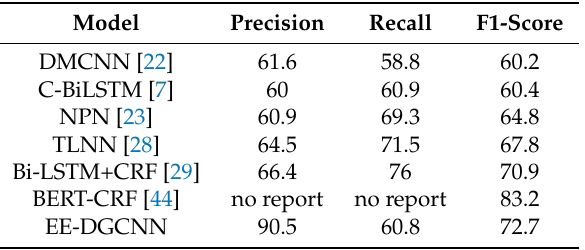
Table 1. Comparison of Chinese event